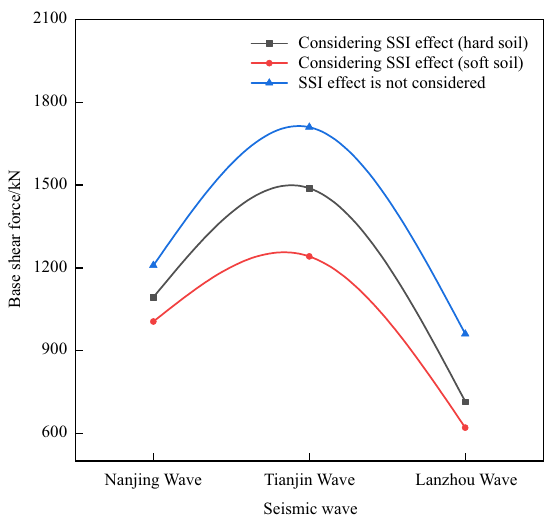
Figure 11. Comparison of base shear force Figure 13. Comparison of shear forces of the core tube: a – shear force of the core tube without considering the SSI effect; b – shear force of the core tube considering SSI effect (hard soil); c – shear force of the core tube considering SSI effect (soft